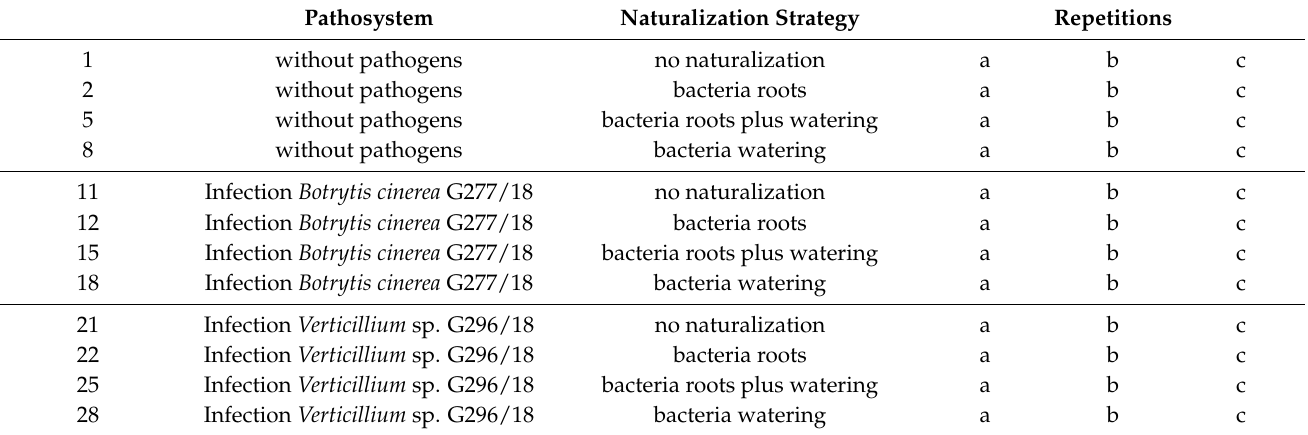
Table A1. Design of plant pot experiment including pathosystems, naturalization strategies and